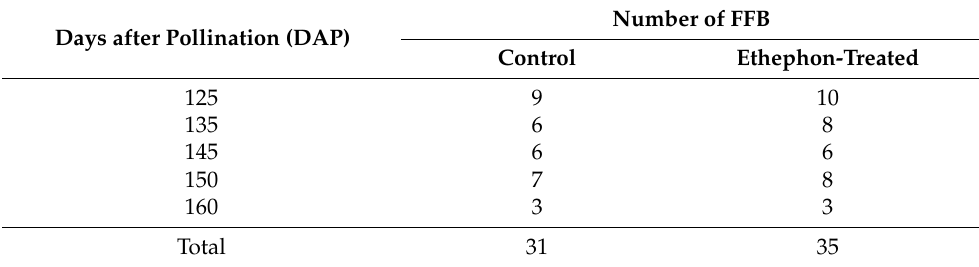
Table 1. Number of fresh fruit bunch (FFB) harvested across different bunch ripeness. Number of FFB Days after Pollination (DAP) Control Ethephon-Treated 125 9 10 135 6 8 145 6 6 150 8 Total 31